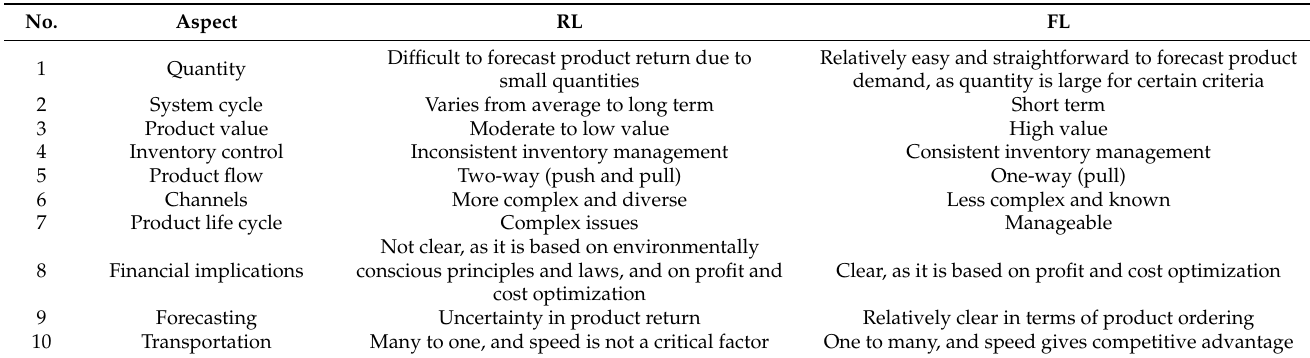
Table 1. Differences between RL and FL